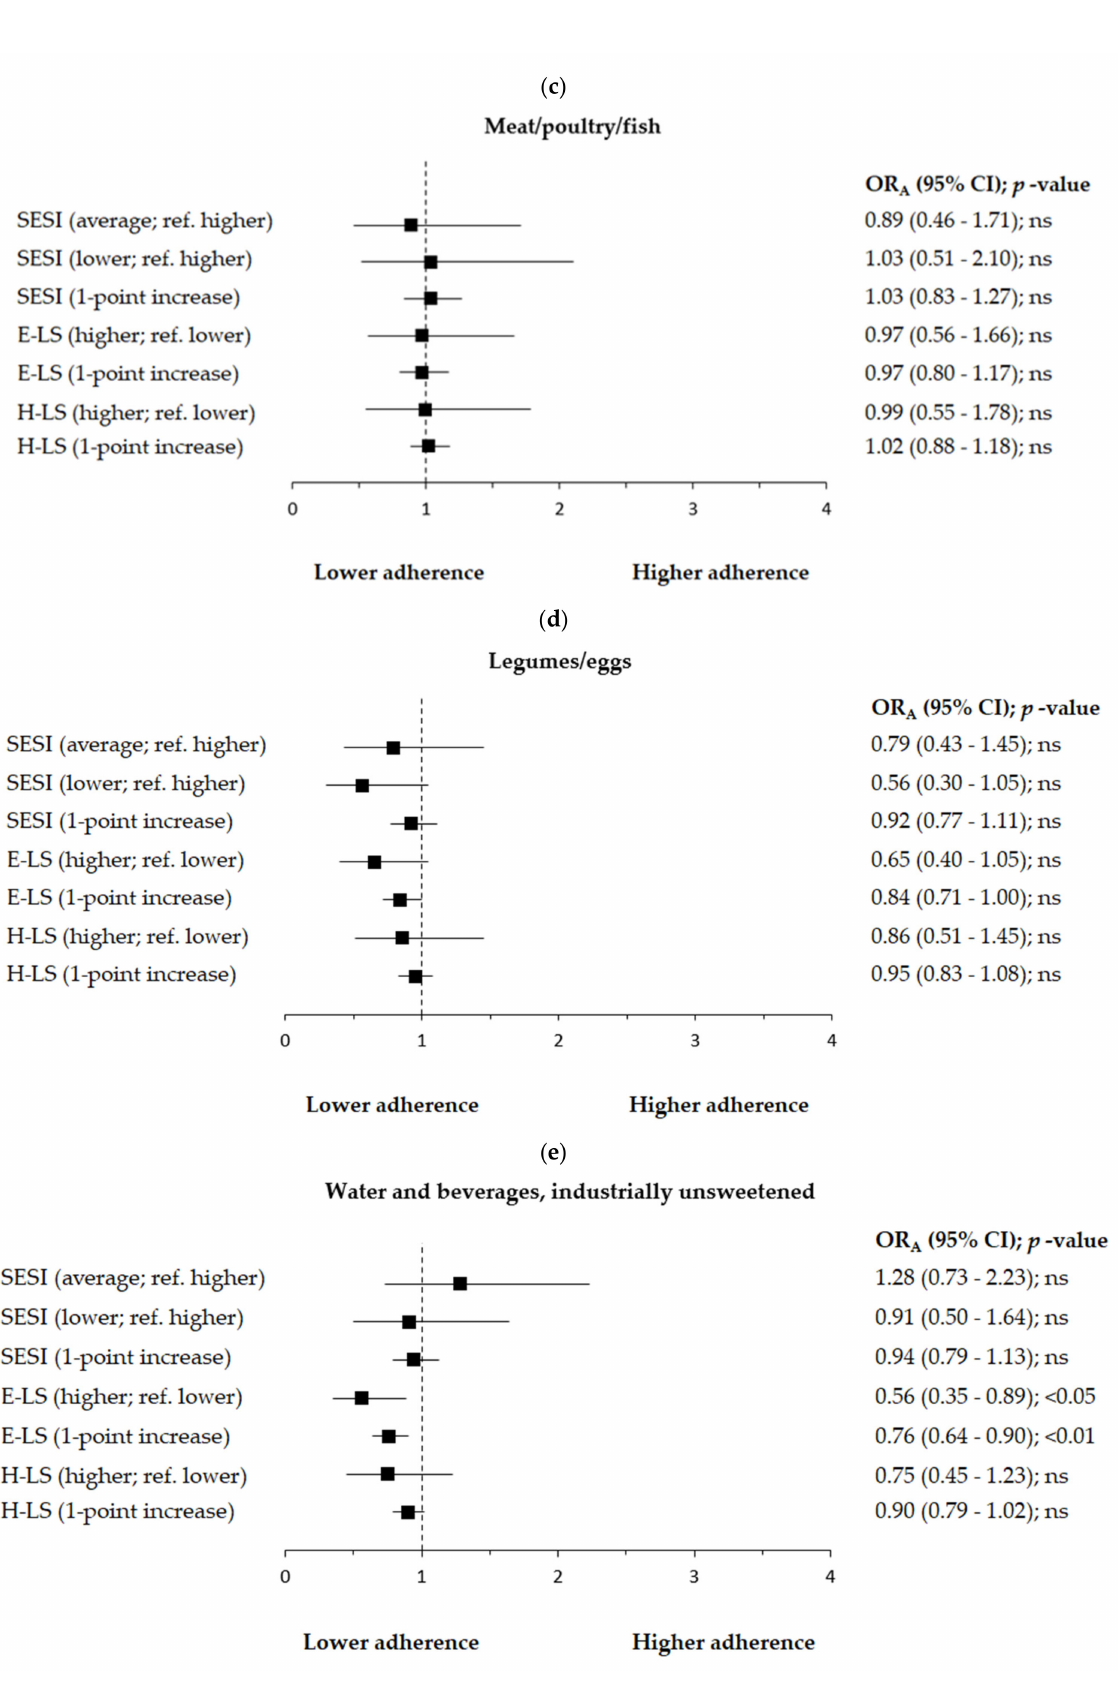
Figure 5. ( a – e ). Factors associated with higher consumption of ( a ) fruit/vegetables ( ≥ 2 servings/day vs. <2 servings/day as reference), ( b ) dairy ( ≥ 1 serving/day vs. < 1 serving/day as